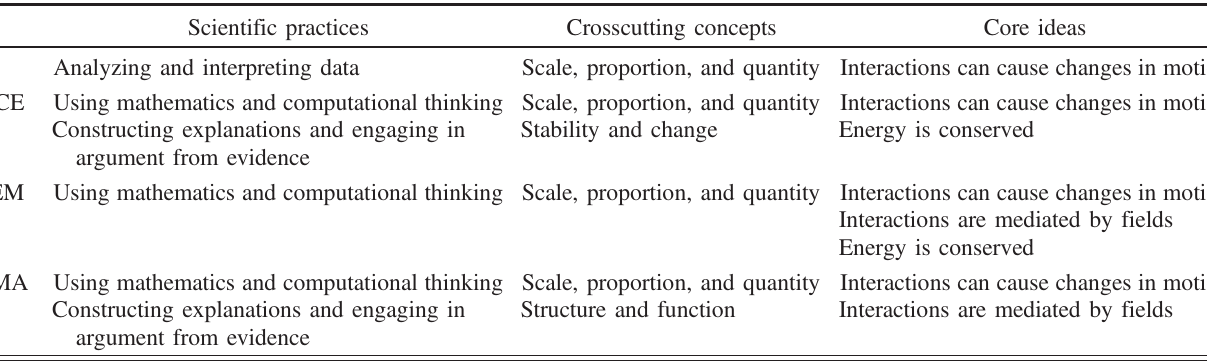
TABLE II. The scientific practices, crosscutting concepts, and core ideas that are potentially being assessed by each of the four concept